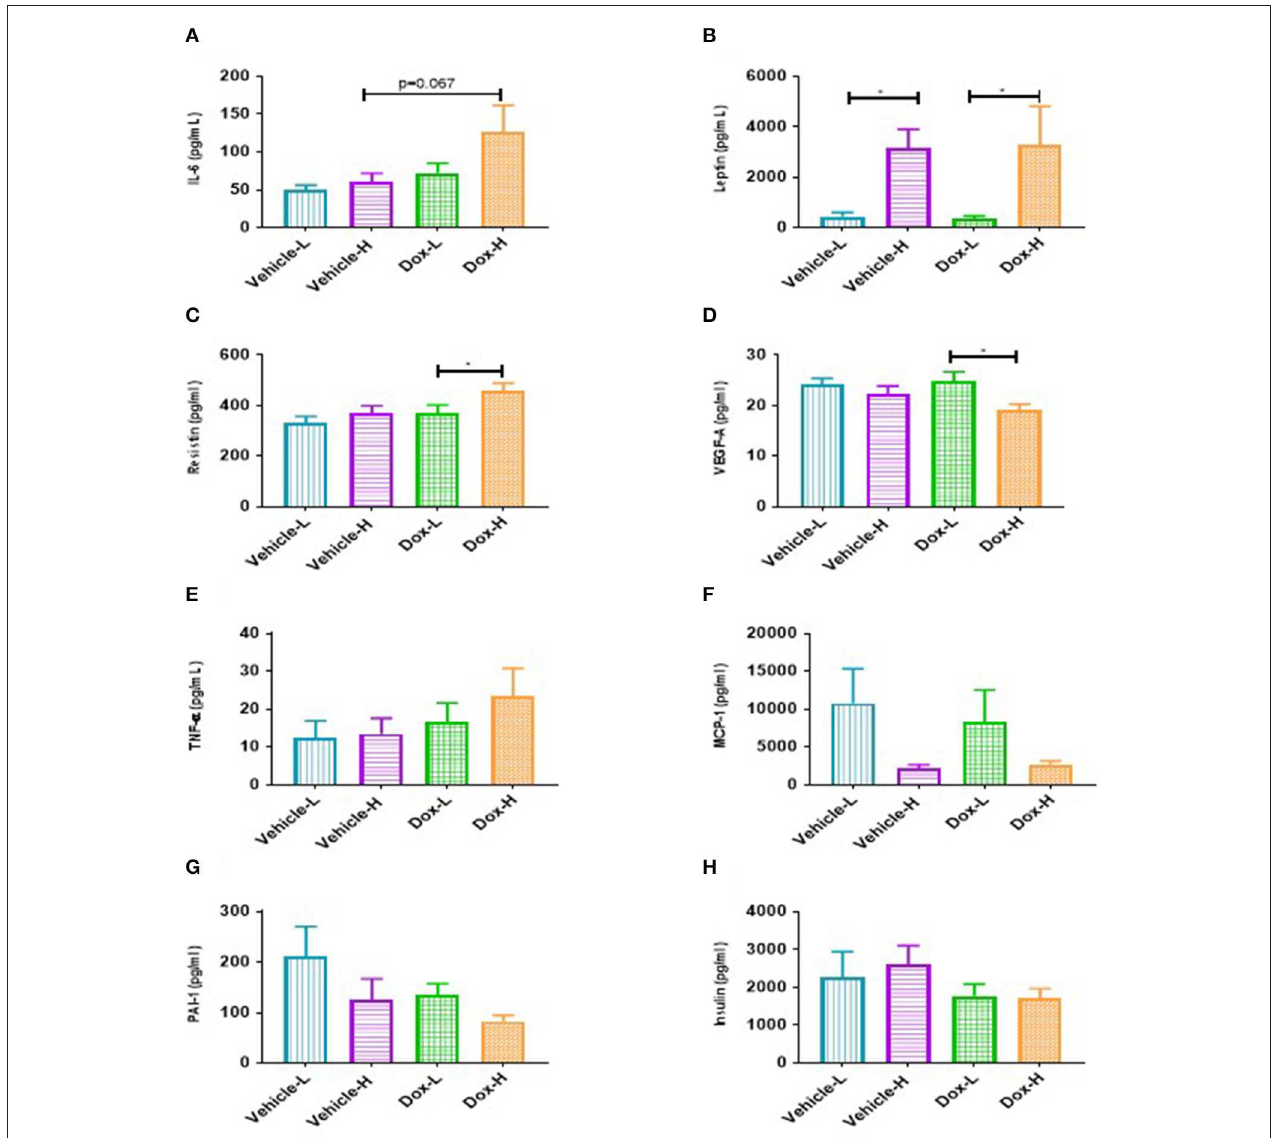
FIGURE 6 | Mean inflammatory marker concentrations for vehicle control and doxorubicin treatment groups on LFD and HFD. (A) , IL-6 (B) Leptin, (C) Resistin, (D) VEGF-A, (E) TNF- α , (F) MCP-1, (G) PAI-1, and (H) Insulin. Results are presented as mean ± SEM ( n = 6–9). Two-way ANOVA with Fisher’s LSD post hoc correction was employed and p < 0.05 was considered as statistically significant. * p < 0.05.